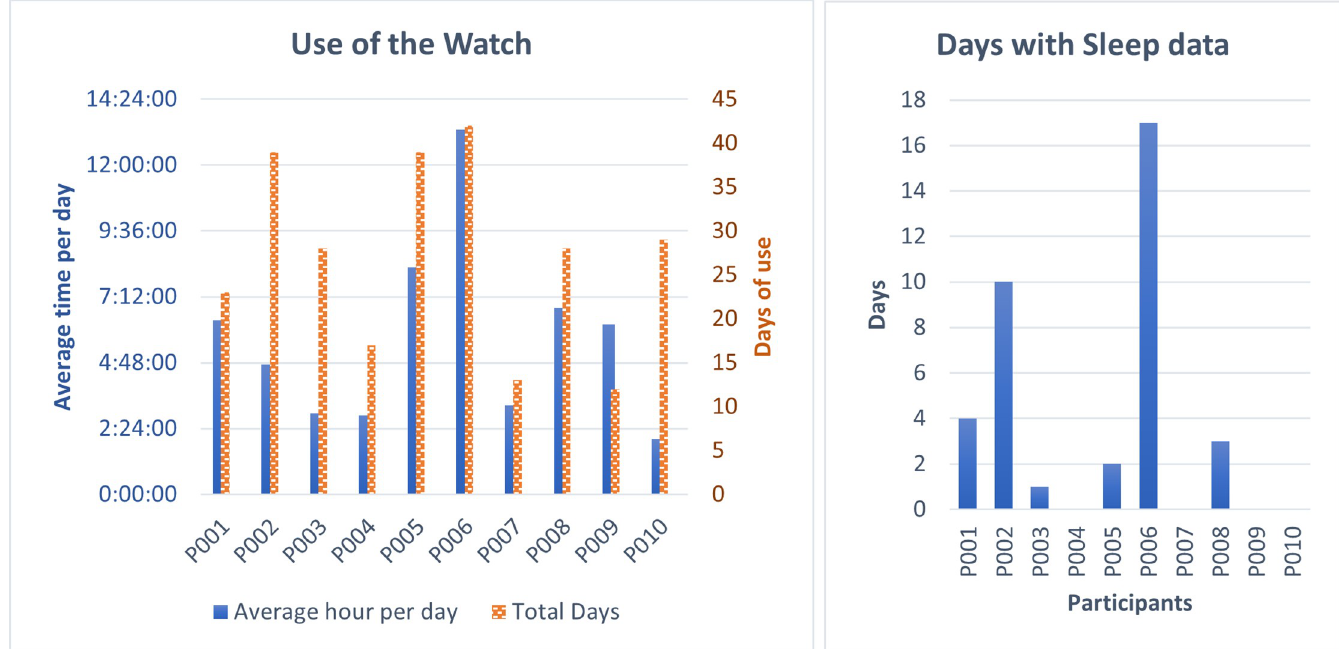
Fig 1. Use of smartwatch. A bar graph showing the estimation of the number of days (y-axis left), and average time (y-axis right) each child worn the smartwatch at any time of the day (left), and at night (right).